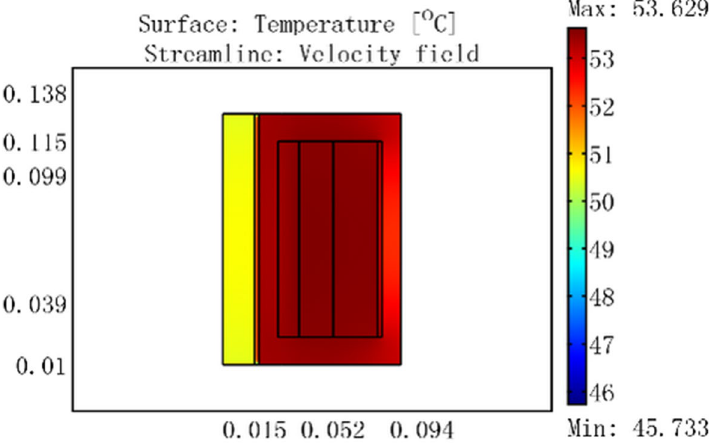
Figure 8. For a current of 3 A, temperature distribution of GMM smart component with no cooling